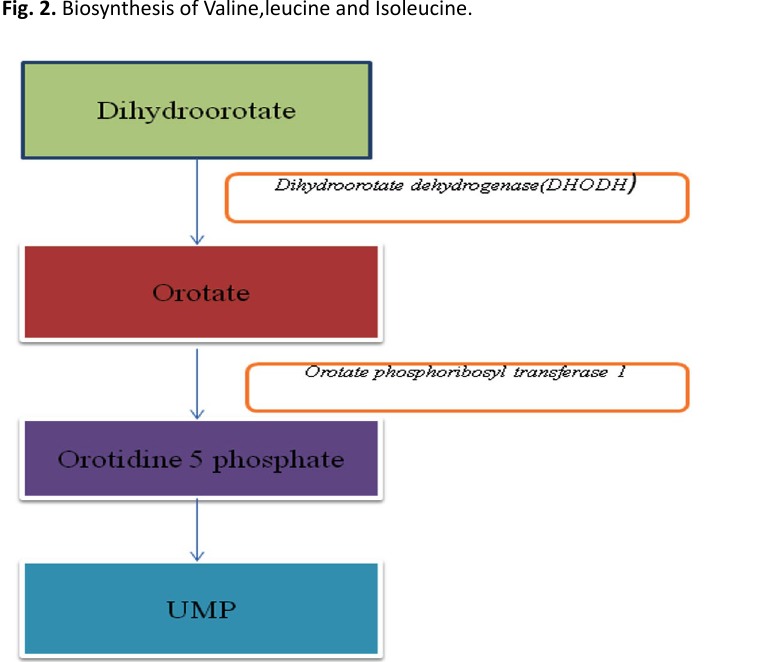
Fig. 3. Biosynthesis pathway of